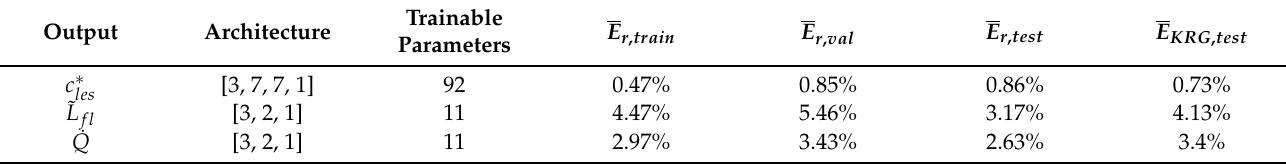
Table 3. List of the best-performing network for each of the presented quantities; and their cor- responding architectures, number of trainable parameters, average relative errors, and equivalent Kriging model